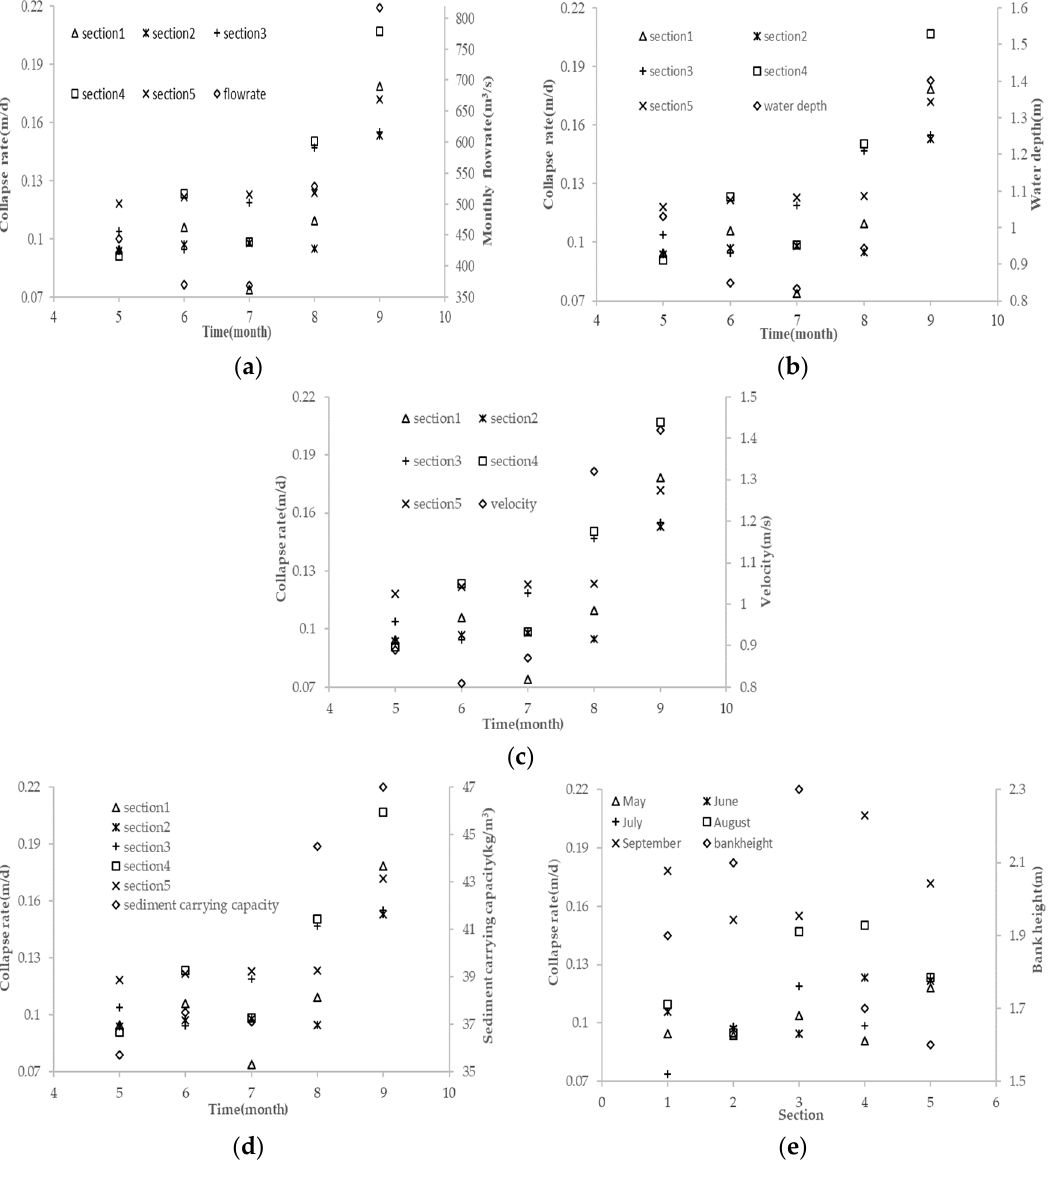
Figure 11. The relationship between flow conditions and collapse rates, the effects of ( a ) flowrate; ( b ) water depth; ( c ) velocity; ( d ) sediment carrying capacity; and ( e ) bank height.